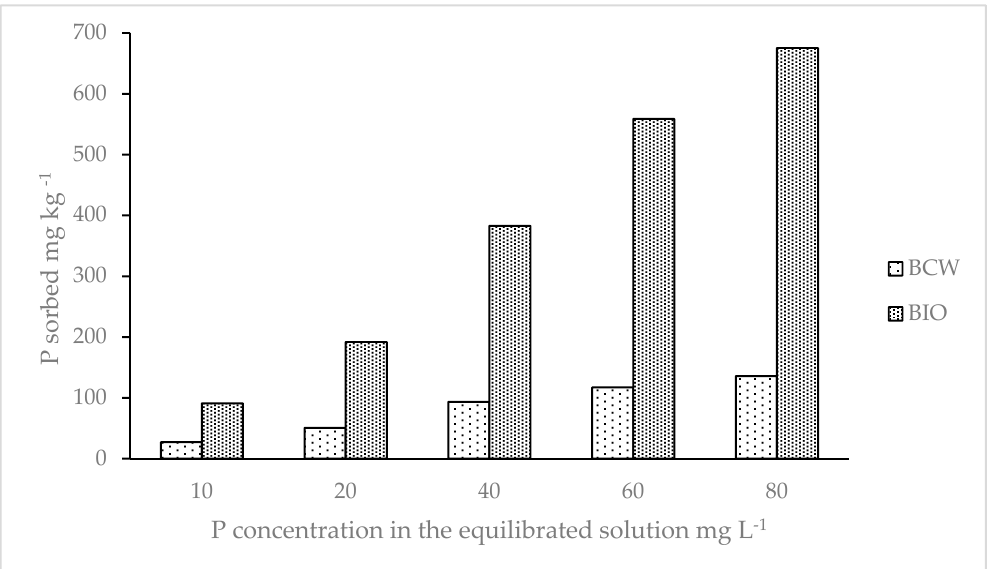
Figure 1. Phosphorus sorption on brown coal waste (BCW) and conifer woodchip biochair (BIO).